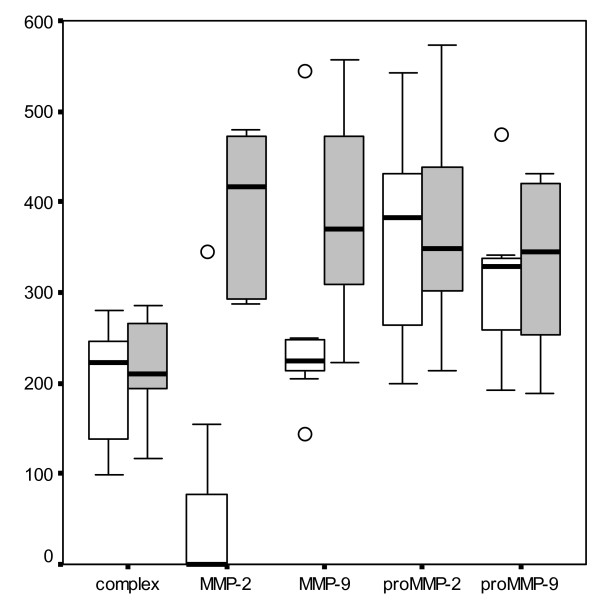
Mean ± s.d. plasma gelatinolytic activity in control group □ and in colic group ■. MMP-9 complex, proMMP-9, MMP-9, proMMP-2 and MMP-2 activities are expressed as an area under the brightness-to-width curve of each gelatinolytic band in zymogram.